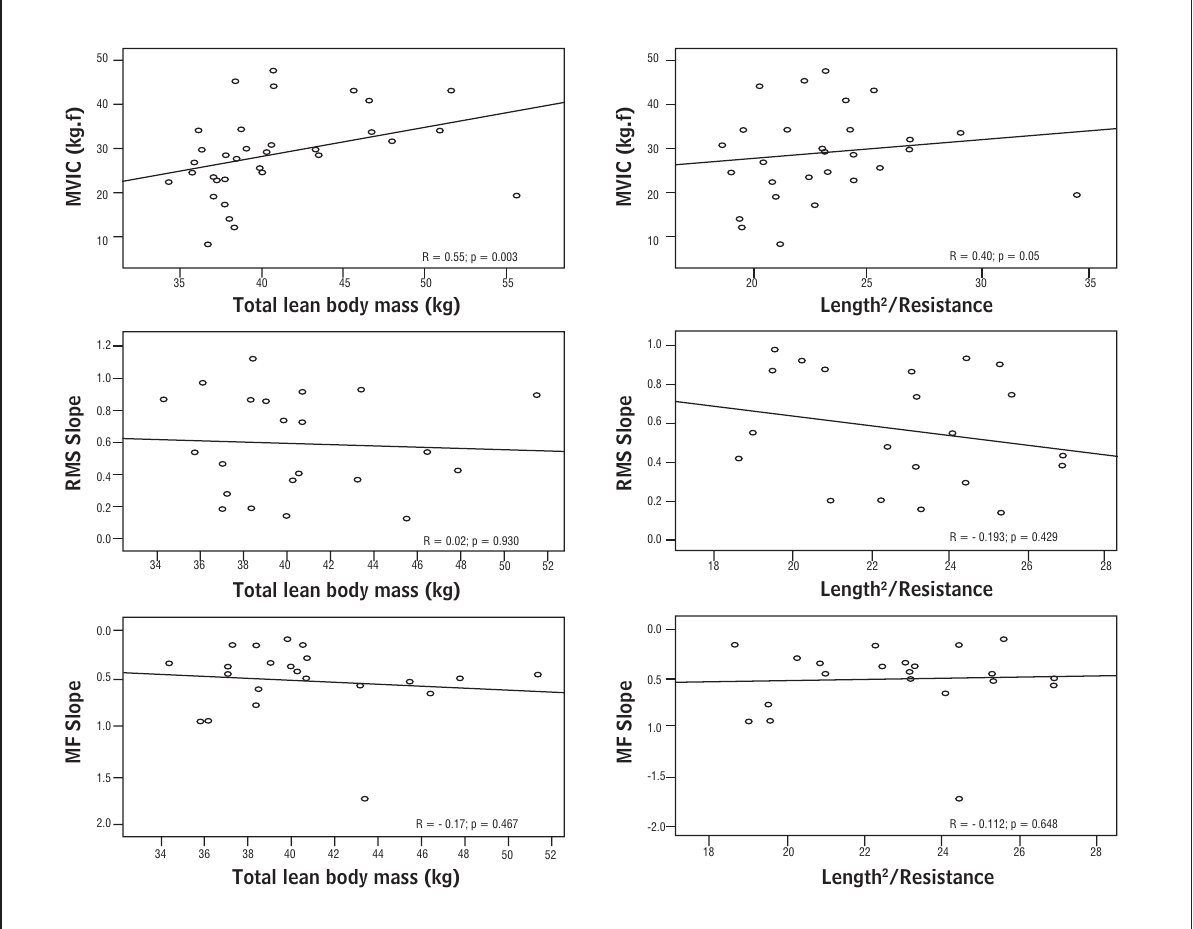
Figure 1 - Scatter point graphs showing the relationships between the values of strength and resistance to fatigue (MVIC – 1 st line, RMS Slope – 2 nd line, and FM Slope – 3 rd line) and the values of total lean body mass and Length 2 /Resistance Note: MVIC = maximal voluntary isometric contraction of the quadriceps; RMS Slope = angle of the linear regression line obtained from the root mean square values of the electromyographic signal during the resistance to fatigue test; MF Slope = angle of the linear regres- sion line obtained from the median frequency values of the electromyographic signal during the resistance to fatigue test; Length 2 / Resistance = ratio of the square of the length of the lower limb to the segmental bioimpedance